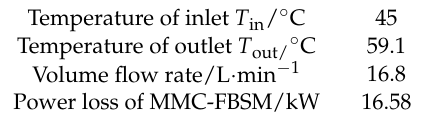
Table 6. Temperature difference between inlet and outlet of heatsink.